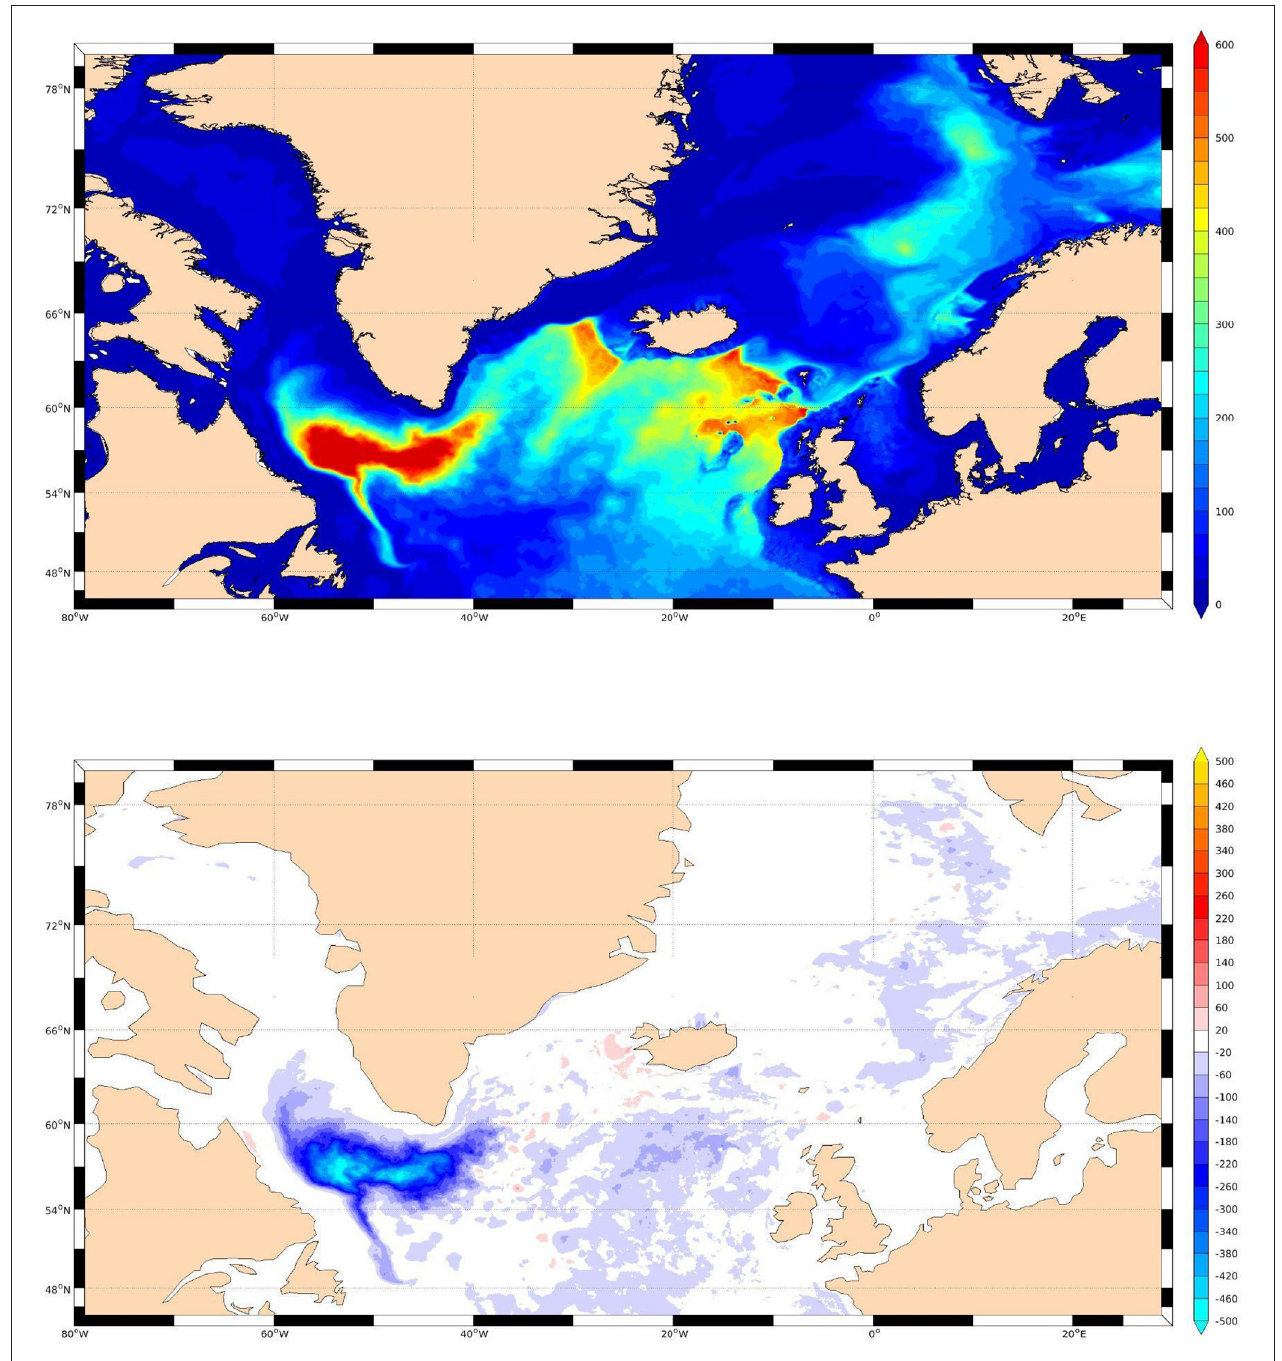
FIGURE 4 | Winter (January–February–March) mixed layer depth (in meters): (upper panel) in the control experiment and (lower panel) anomaly between the control and sensitivity experiments, both shown as multiyear (2004–2016) averages.